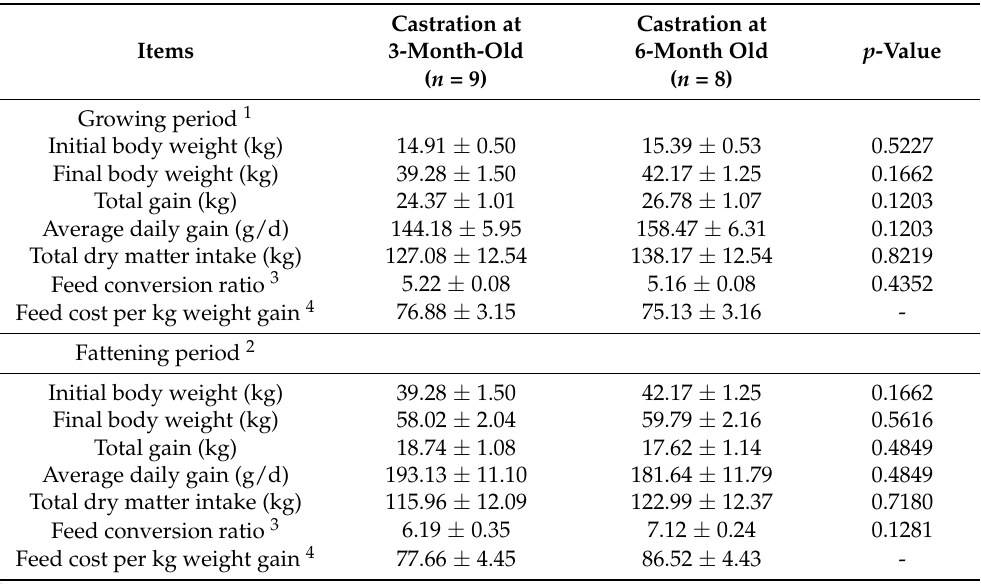
Table 2. Effects of castration at different ages on the growth performance of Nubian crossbred male goats in the growing period and fattening period (LSM ±